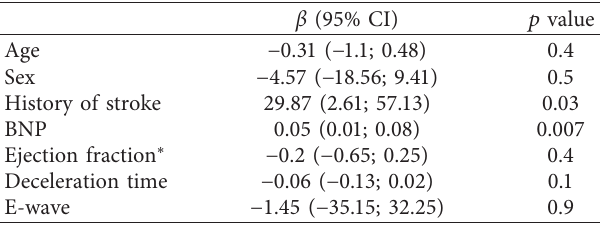
Table 3: Combined, mixed effect model for the relationships of atrial fibrillation burden and clinical, laboratory, and left atrial echocardiographic